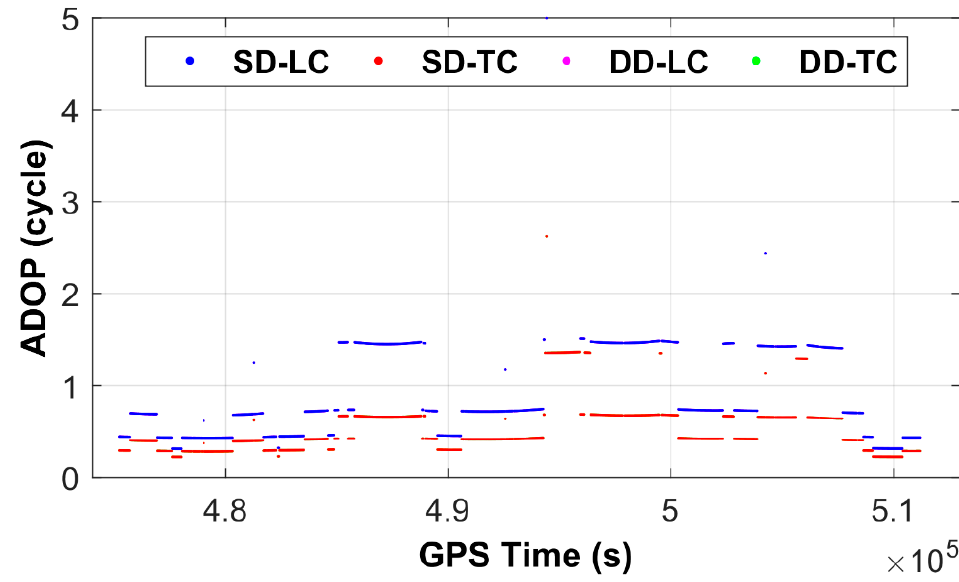
Figure 3. ADOP series of the DD-LC, DD-TC, SD-LC, and SD-TC models under a 40° elevation cutoff angle in the single-epoch solution.